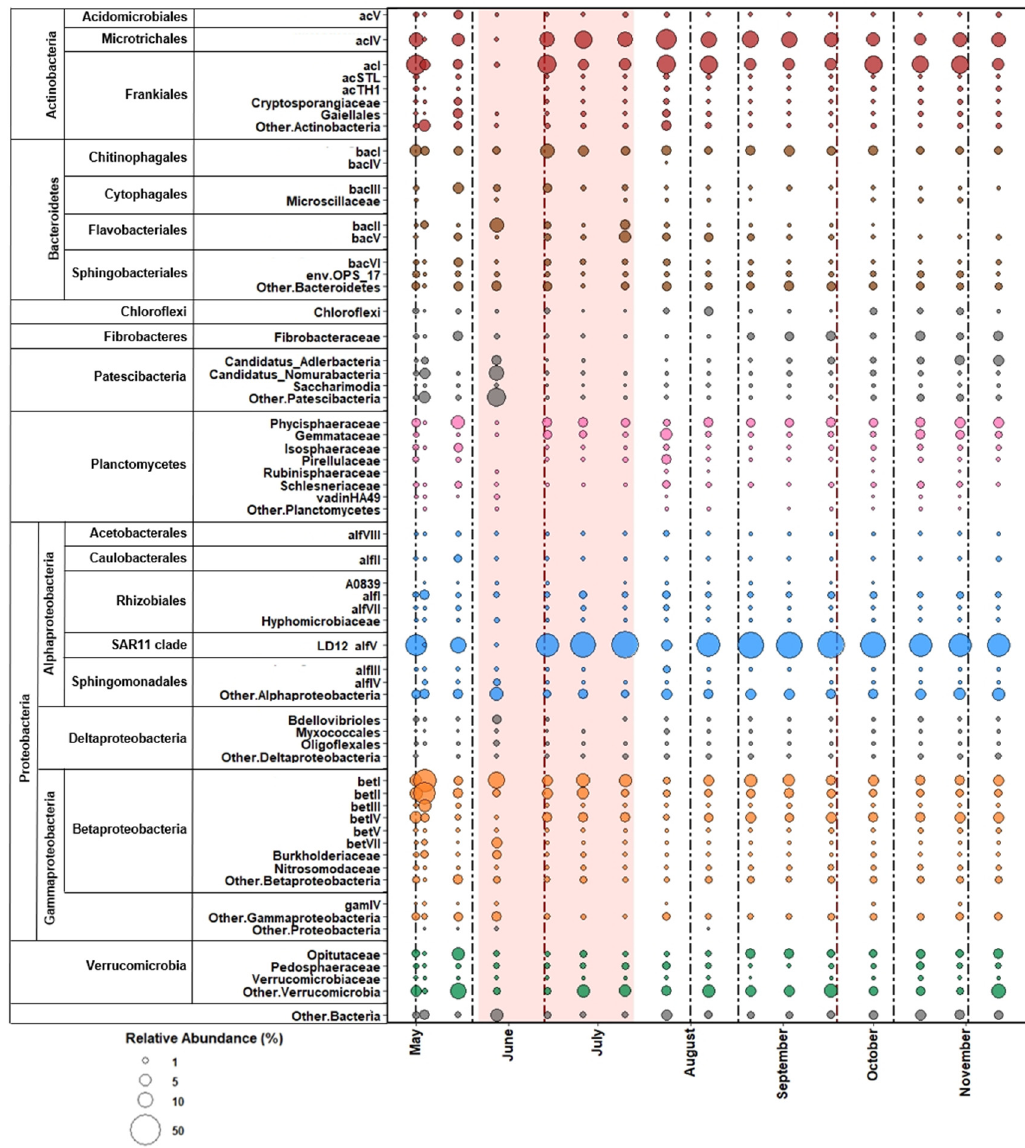
Figure 4. Bubble plot of the free-living bacterial abundance in Lough Feeagh. Dotted vertical lines indicate the onset of weather events. The pale red shaded area indicates the drought period.